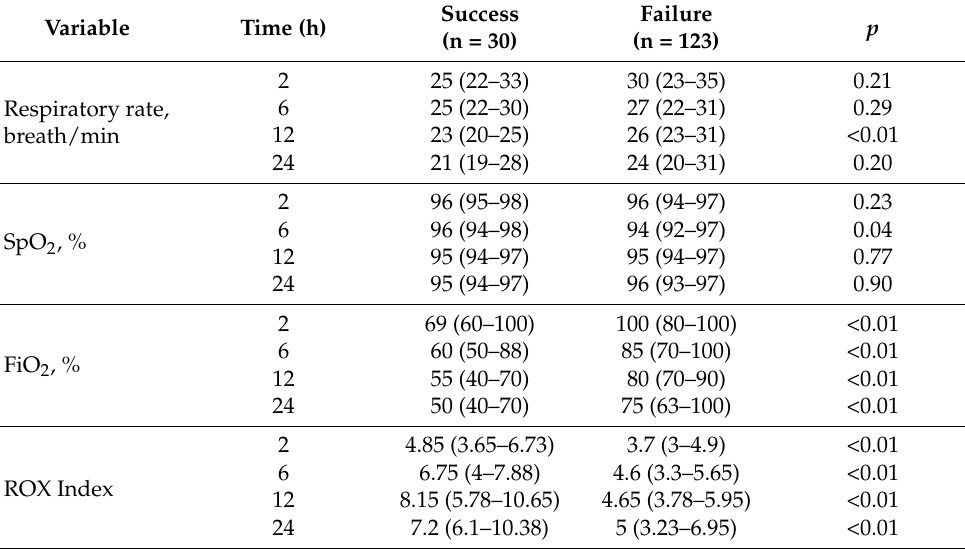
Table 4. Respiratory rate, peripheral saturation of oxygen (SpO 2 ), inhaled fraction of oxygen (FiO 2 ), and ROX index at 2, 6, 12, and 24 h after the high-f low nasal cannula initiation. Data are presented as median (interquartile